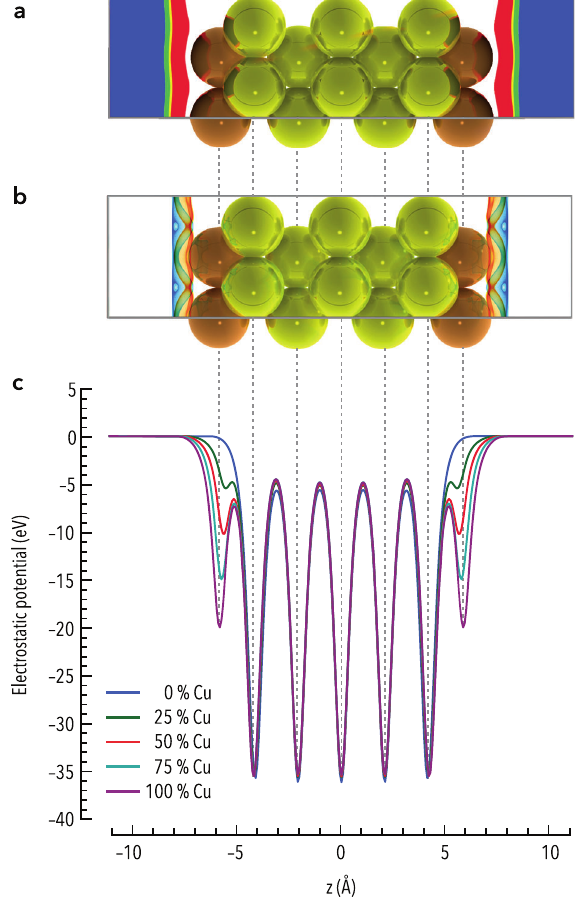
Fig. 2 a Dielectric cavity of the continuum solvent. The transparent region is associated with ε 0 = 1, which transitions outside of the electrode surface to the blue region where ε 0 = 78.3. b Polarization charge density that arises along the surface of the dielectric cavity. Positive polarization charges are shown in red , negative charges in blue . c The electrostatic potential for each copper covered surface is aligned to zero in the bulk of the continuum solvent region. The perturbation of the outermost peak is related to the change in surface dipole moment due to the adsorption of copper ions for increasing